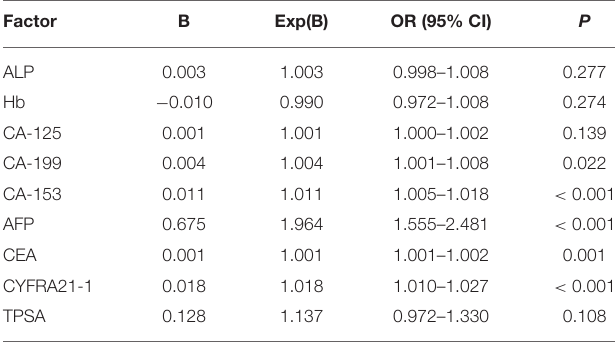
TABLE 3 | Results of binary logistic regression to identify risk factors for ocular metastasis of lung cancer. Factor